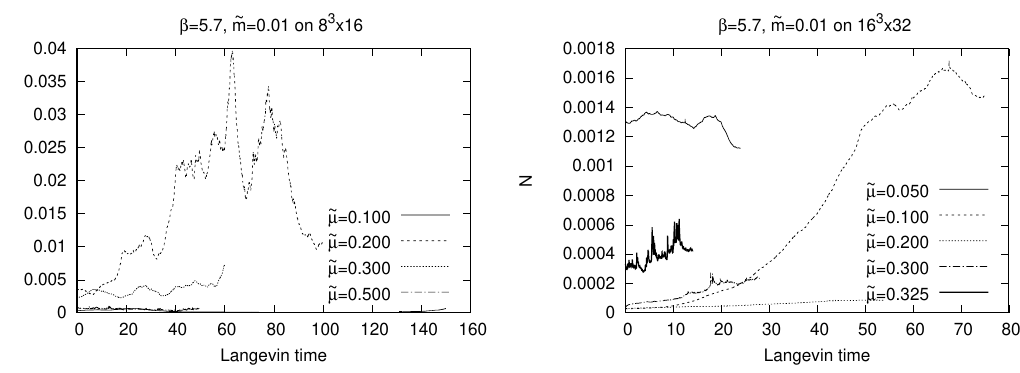
Figure 3 . The Langevin-time histories of the unitarity norm (starting from the initial con(cid:12)guration) are plotted for (cid:12) = 5 : 7 and ~ m = 0 : 01 on the 8 3 (cid:2) 16 lattice (Left) and the 16 3 (cid:2) 32 lattice